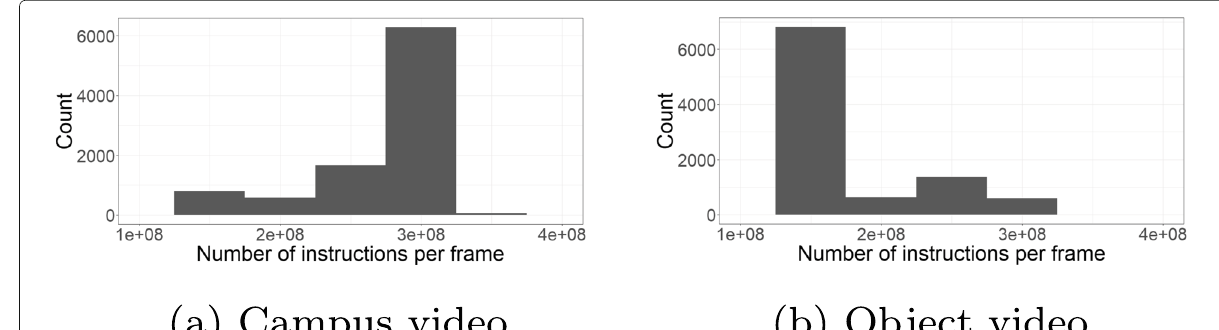
Fig. 8 Measured number of instructions per